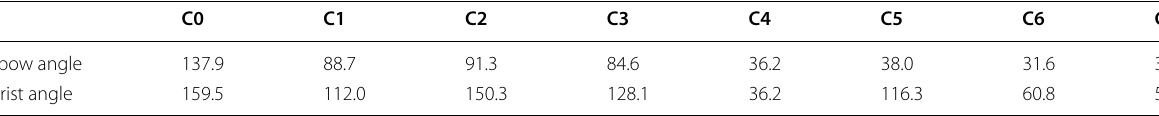
Table 1 Median values of elbow- and wrist-joint